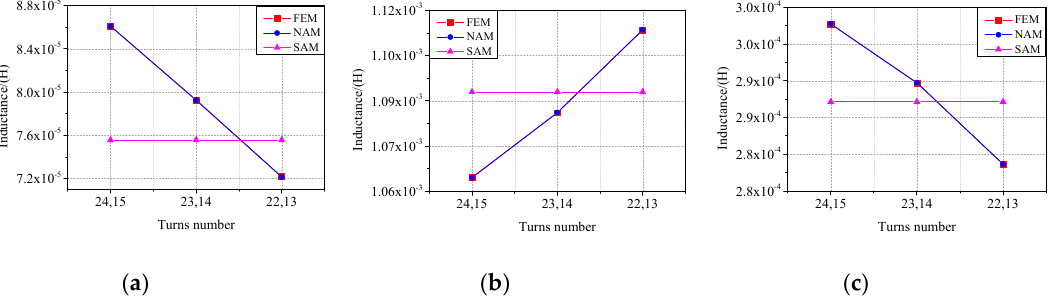
Figure 12. The inductances of the faulty coil when there are 10 turns shorted in layer 2: ( a ) self-inductance in faulty part; ( b ) self-inductance in healthy part; ( c ) mutual inductance.